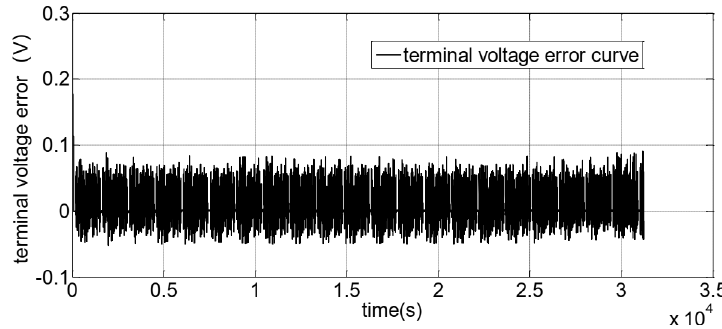
Figure 5. The terminal voltage error